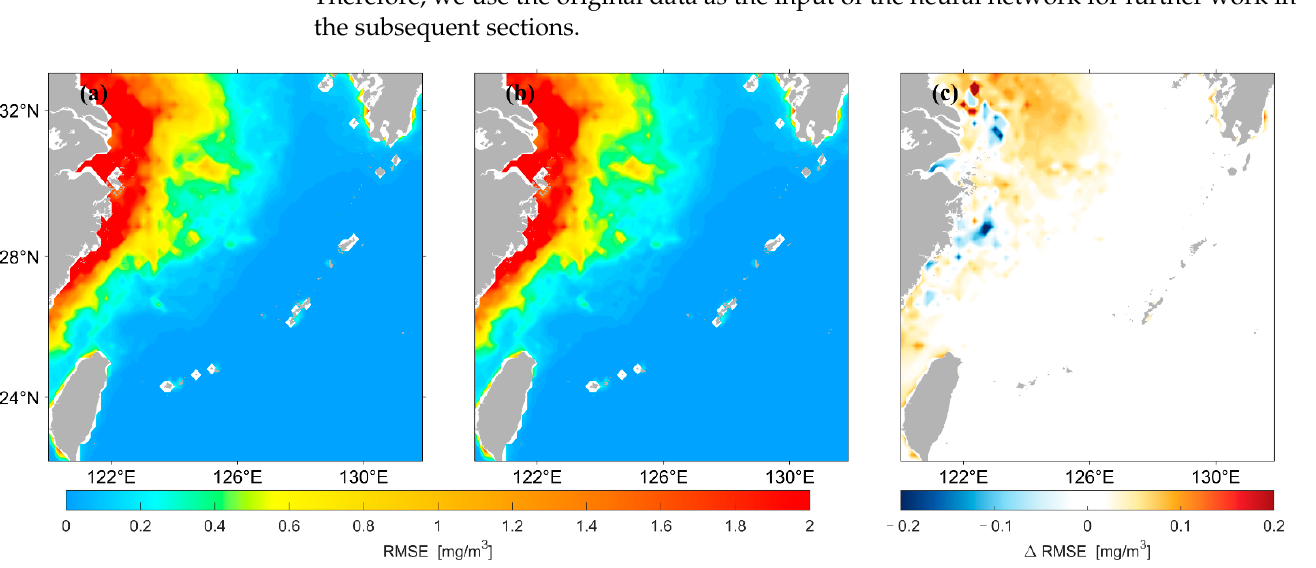
Figure 8. Spatial distribution of RMSE of Chl-a predicted by the two LSTM models. ( a ) is the result predicted using the original data as input, ( b ) is the result predicted using the logarithmic data as input, ( c ) represents ( a , b ).